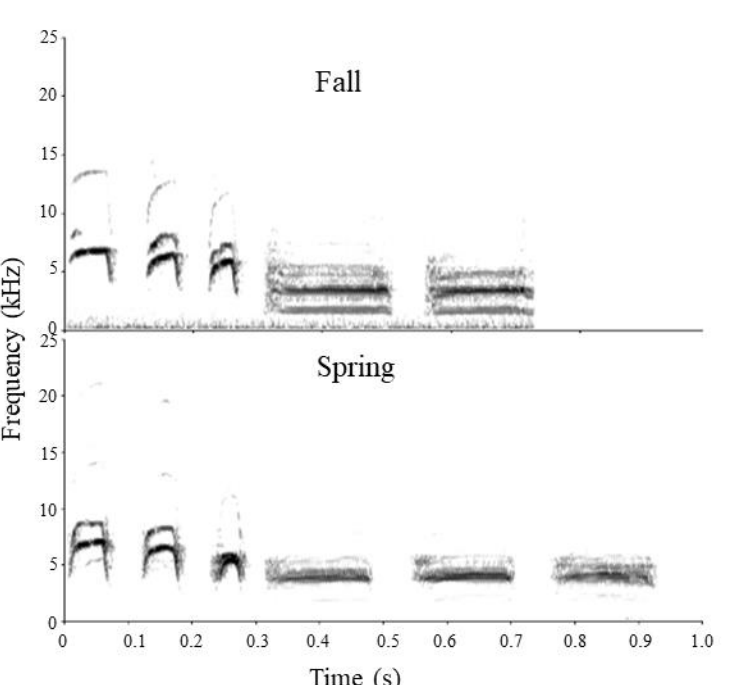
Figure 1 . Spectrograms of calls produced in fall and spring. Male black-capped chickadee chick-a-dee calls produced by two different individuals. Total duration is 1